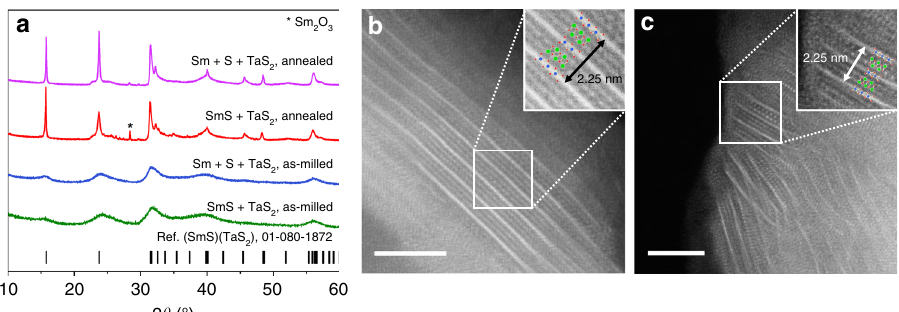
Fig. 2 Mechanochemical synthesis of the (SmS)(TaS 2 ) heterostructure. a PXRD patterns of (SmS)(TaS 2 ) obtained by ball milling of SmS and TaS 2 , or Sm, S, and TaS 2 in the planetary mill for 30 h, and of the respective materials annealed at 1000 °C for 3 days. PXRD patterns of the starting materials, SmS and TaS 2 , are presented in Supplementary Information. b , c HAADF-STEM images of respective as-milled samples. The insets display enhanced views of the 3D heteroatomic moieties. Scale bars,